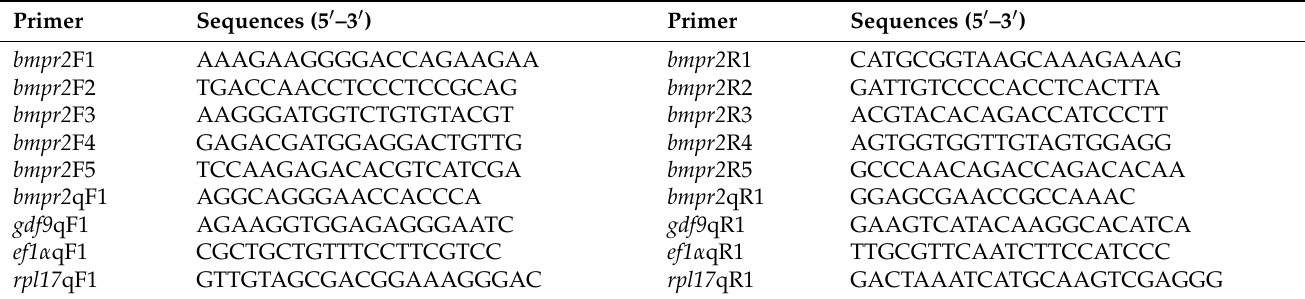
Table 1. Primers used for cloning and